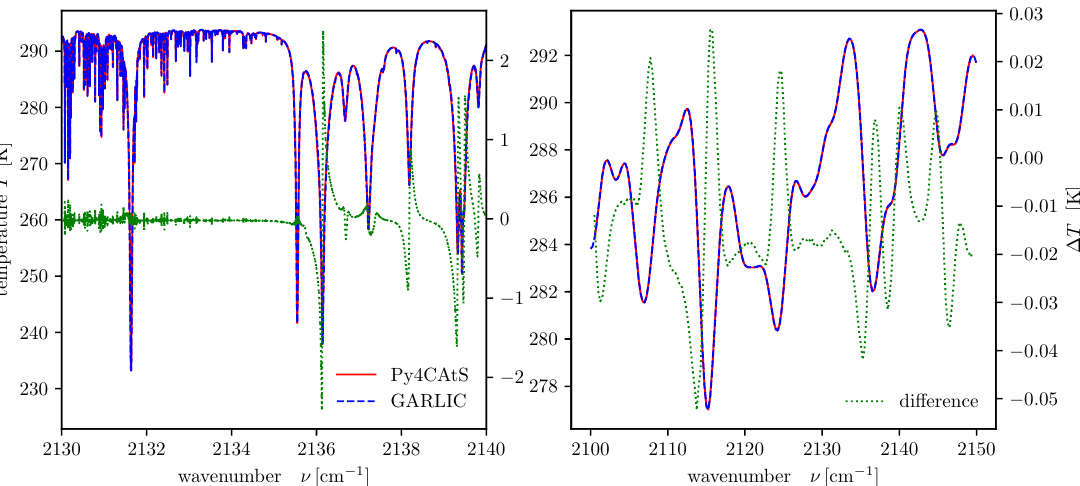
Figure 8. Intercomparison of equivalent brightness temperature spectra with corresponding spectra generated with GARLIC and their difference (axis on right). Midlatitude summer atmosphere, downlooking observer at ToA with viewing zenith angle 180 ◦ . ( Left ) monochromatic spectra; ( Right ) radiance convolved with a Gaussian response function with HWHM = 1 cm − 1 . The Py4CAtS spectra have been generated with vLimits = Interval(2100.0,2150.0) mls = atmRead(’/data/atmos/50/mls.xy’, zToA=100) dll = higstract(’/data/hitran/2000/lines’,vLimits+20, ’main’) # dict. of line lists radNadir = dod2ri(lbl2od(mls,dll,vLimits+5),180.,mls[’T’][0]) # monochrom radiance radNadirG = radNadir.convolve(1.0,’G’) # Gauss spectral response btNadir = radiance2Kelvin(radNadir.grid(),radNadir) # equ brightness temperature btNadirG =